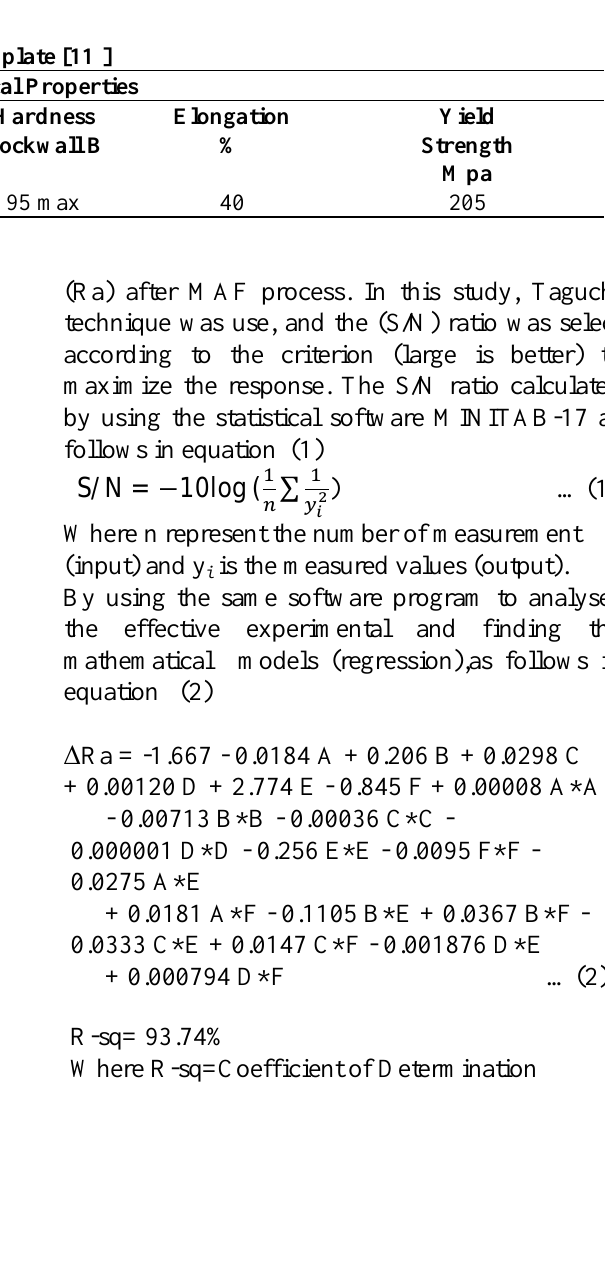
Table 4, Some mechanical properties of stainless steel type 316 plate [11 ]